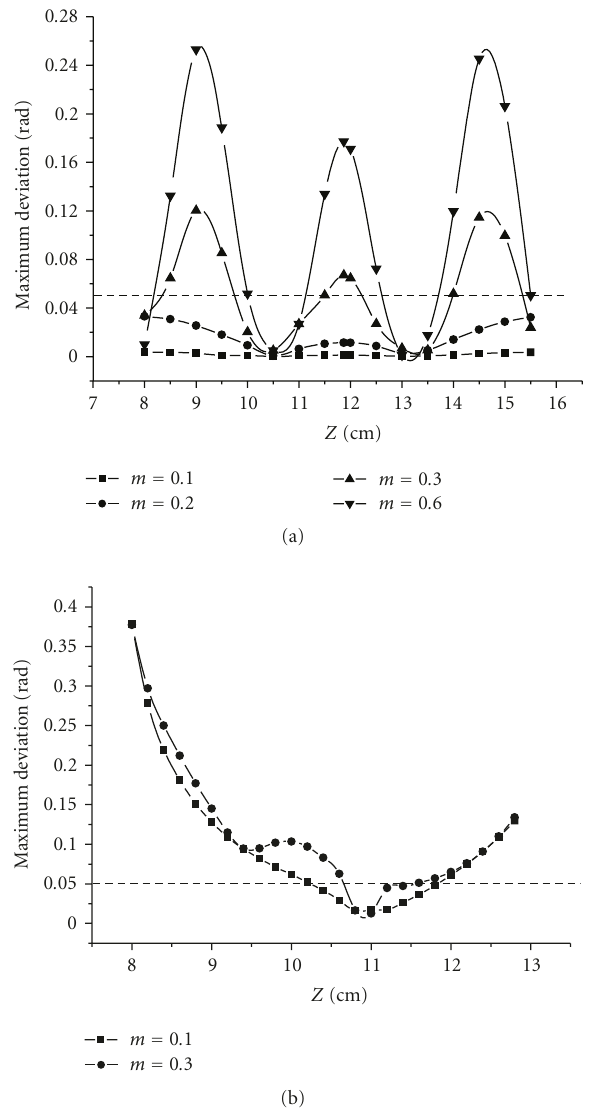
Figure 7: Maximum deviation of the di ff erence between the phase estimate and the real-phase value for reconstruction of a plane surface at plane-wave illumination: (a) one-wavelength projection; (b) four-wavelength projection. Here, z is the distance between the grating and the plane.